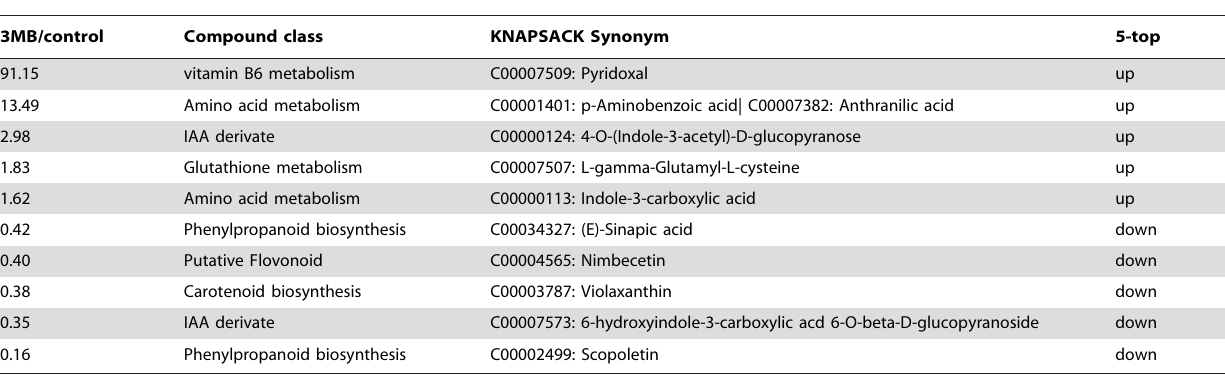
Table 2. PARP inhibition altering secondary